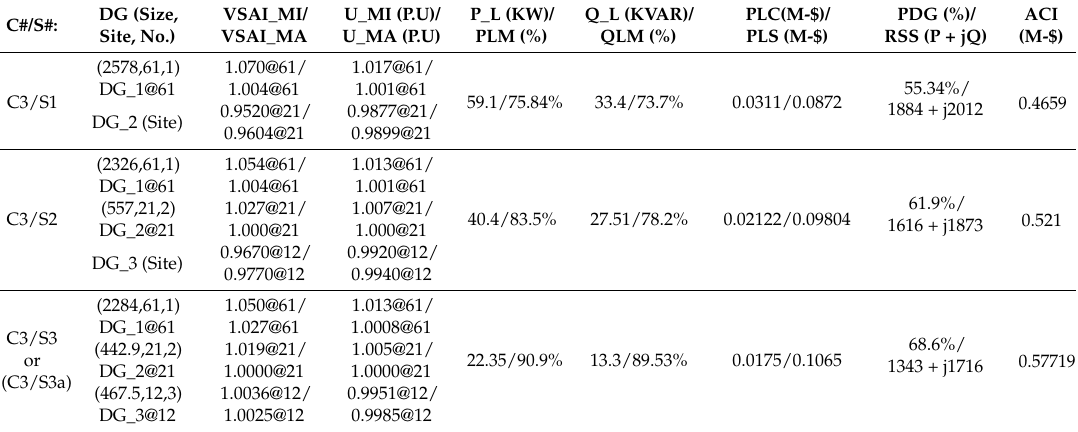
Table 5. Results of proposed planning approach under Case 3 (69-bus-MDS) aim at